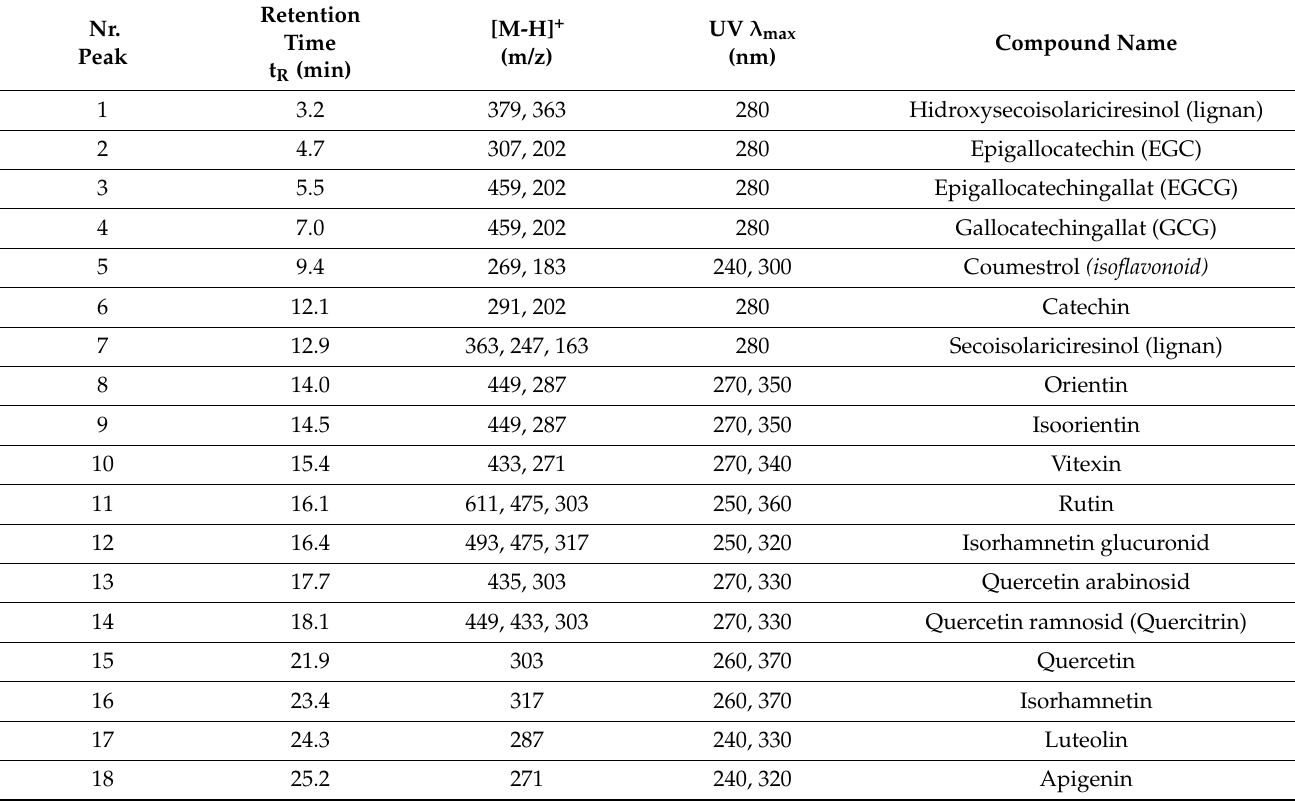
Table 2. Retention time, wavelength characteristic of maximum absorption, and ion monitored in MS for phenolic compounds identified in samples.